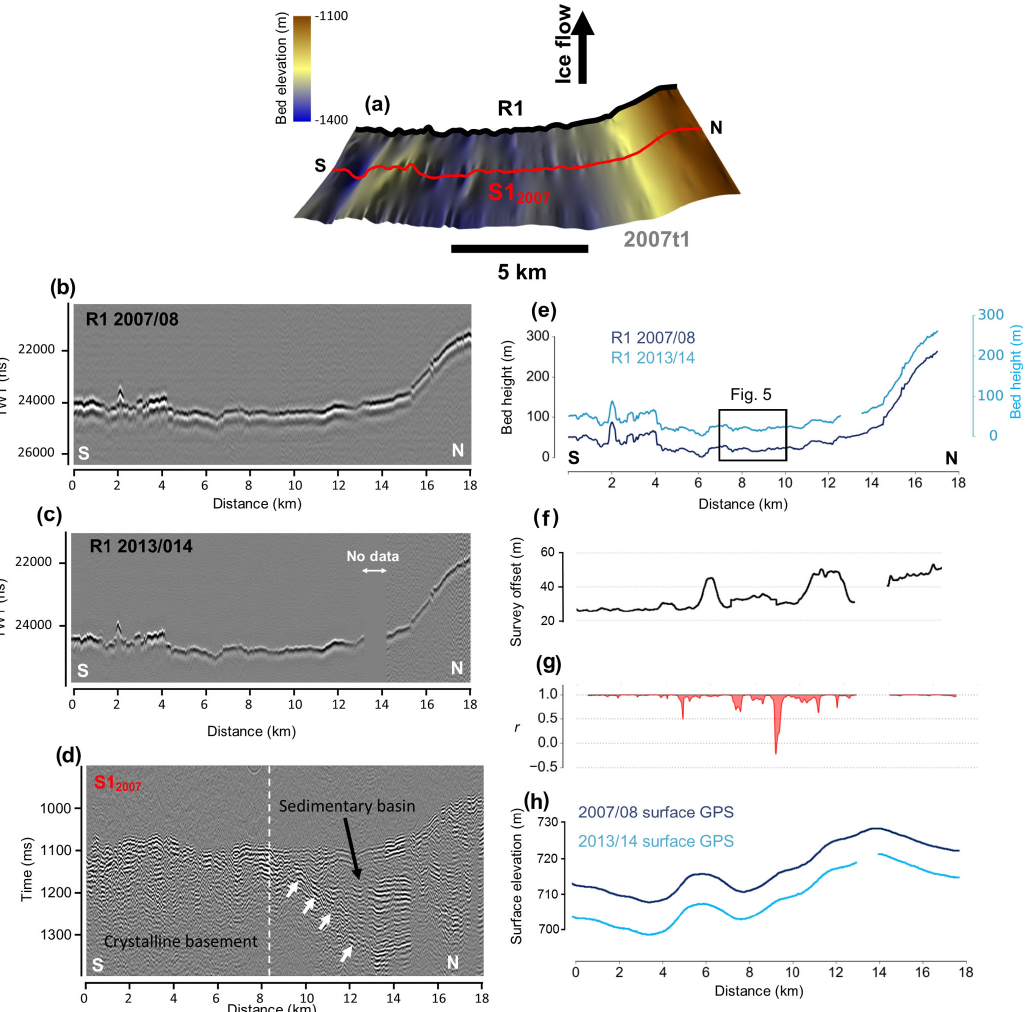
Figure 2. Geophysical data and bed picks from PIG. (a) Radar derived DEM from PIG showing the location of radar (black line) and seismic survey (red line). (b, c) processed radargrams of repeat radar surveys. (d) Processed seismic section of S1 (Smith et al., 2013). White arrows denote a dipping reflector demarcating a sedimentary basin. (e) Bed picks from repeat radar survey R1. (f) Plot showing the survey divergence between radar profiles in 2007/2008 and 2013/2014. (g) Correlation coefficient of repeat bed picks between 2008/2009 and 2013/2014 across a 500m moving window. (h) Plot of surface elevation profiles derived from differential GPS